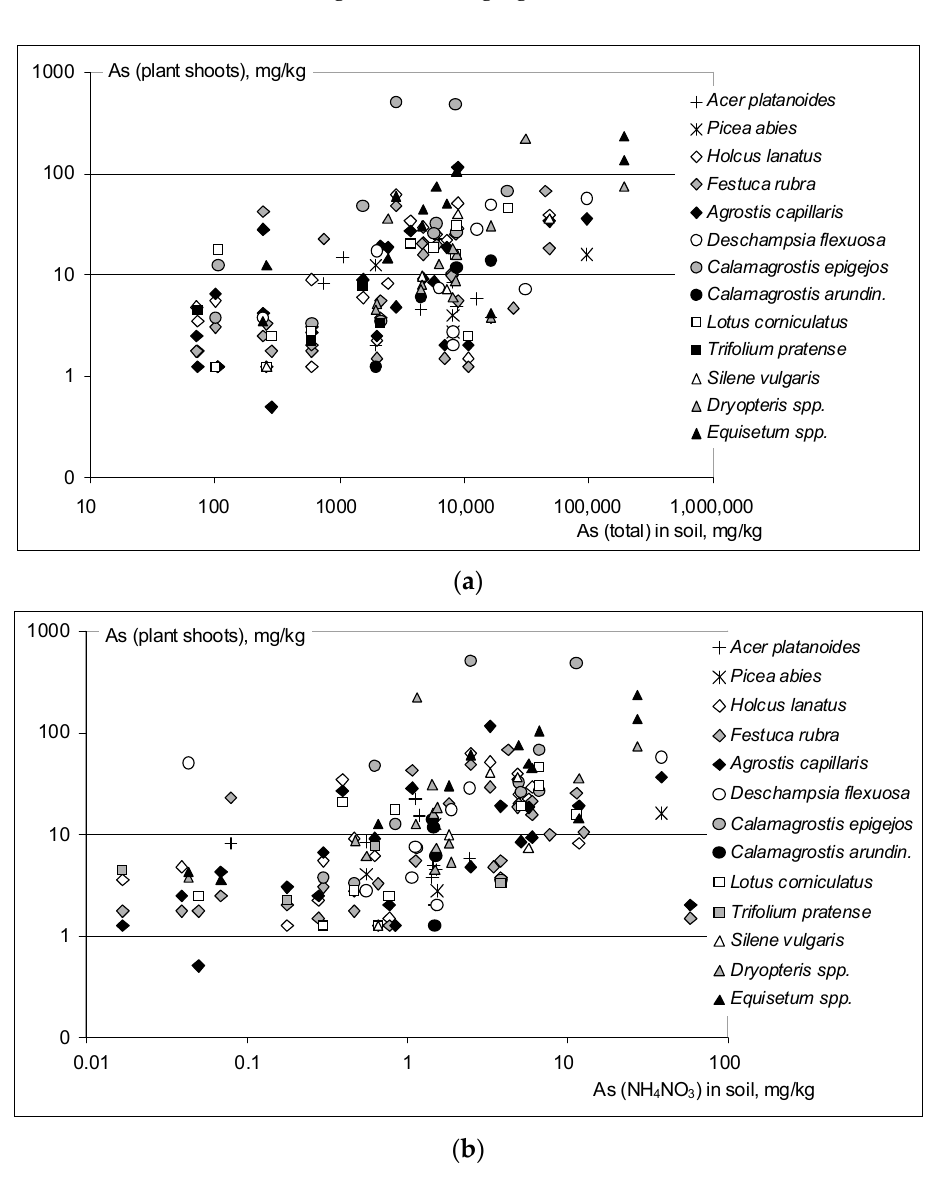
Figure 3. Arsenic concentrations in the aboveground parts of plants, as related to soil As. Graph ( a ) illustrates the relationships between As in the aboveground parts of plants and total soil As, and graph ( b ) relates the concentrations of As in the aboveground parts to 1M NH 4 NO 3 -extractable As in soils.